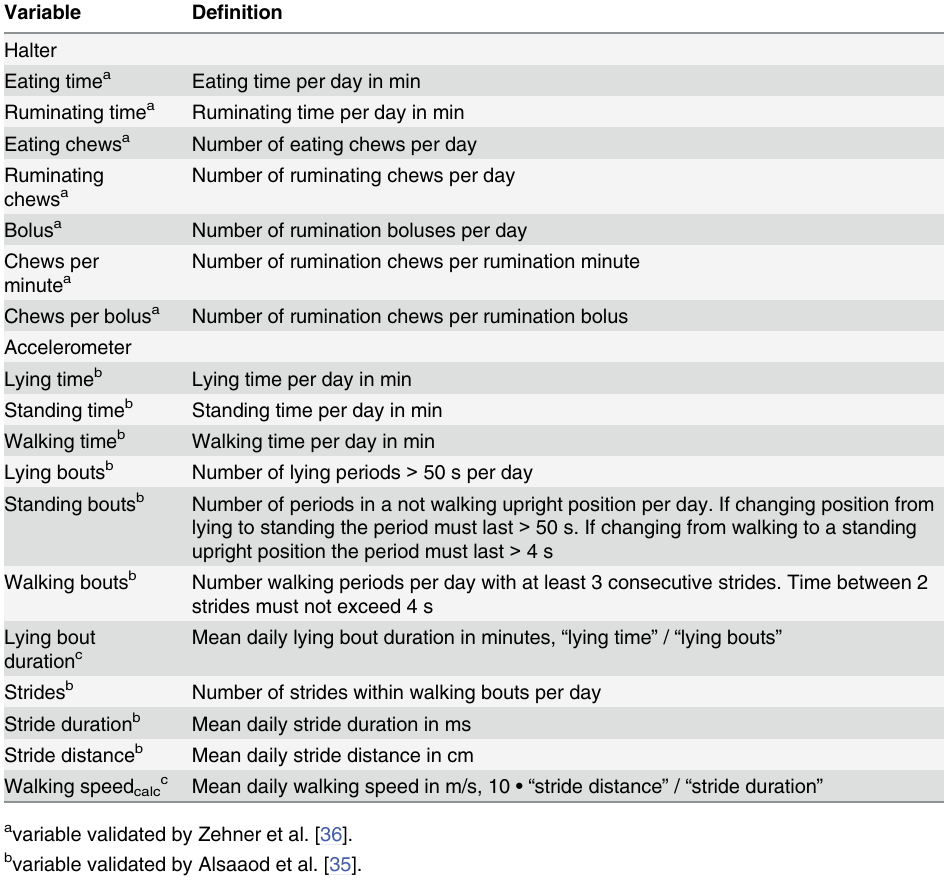
Table 1. Variables of RumiWatch noseband sensors and 3D-accelerometers (RumiWatch, ITIN+HOCH GmbH, Fütterungstechnik, Liestal, Switzerland).